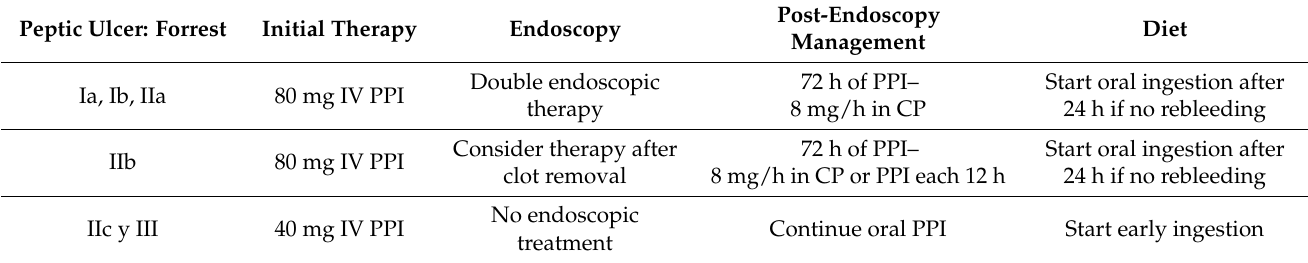
Table 1. Summary pre-endoscopy and post-endoscopy